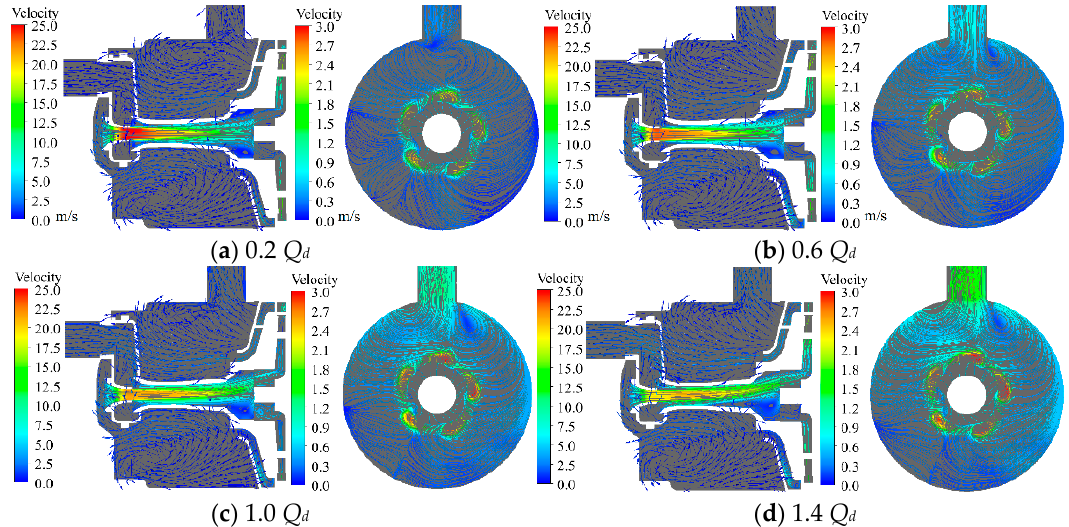
Figure 4. Velocity vector and streamline diagrams under different working conditions.